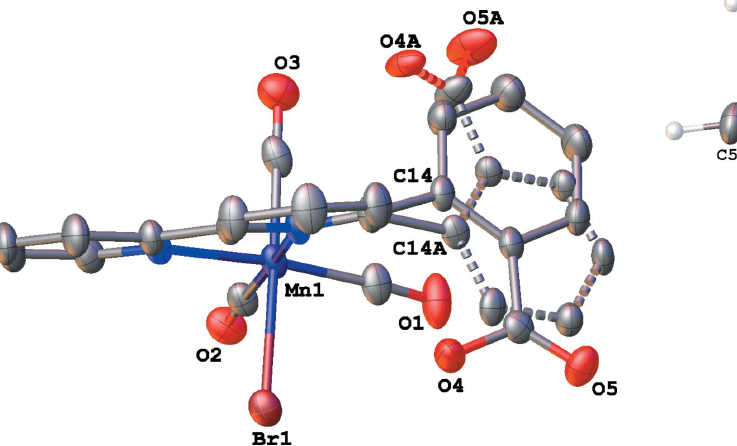
Figure 1 The molecular structure of compound I , with partial atom labeling and 50% probability displacement ellipsoids. Both disorder components of the benzoic acid group are shown (the minor one with dashed lines), and H atoms have been omitted for clarity.